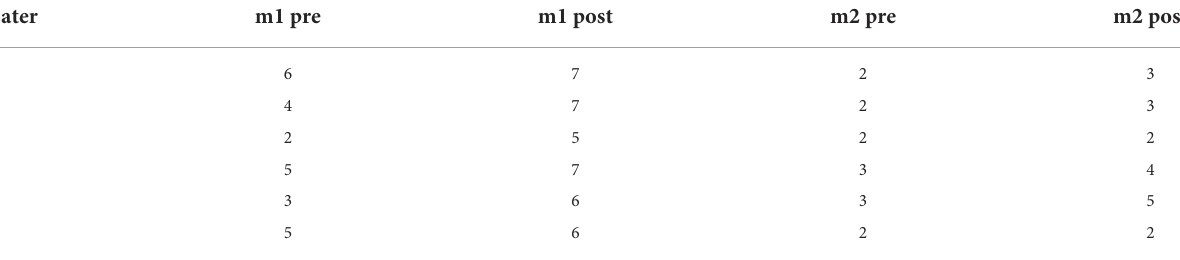
Table A2 Initial (pre) and final (post) scores given by the six female speakers (in rows) to the two male speakers (in columns).